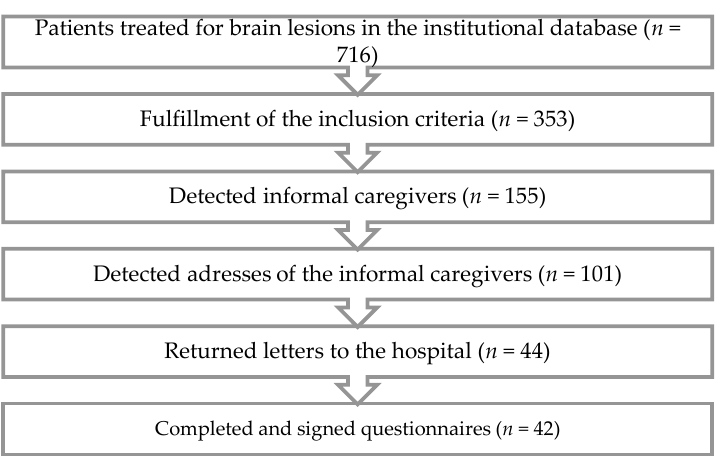
Figure A1. Selection process of the study population.